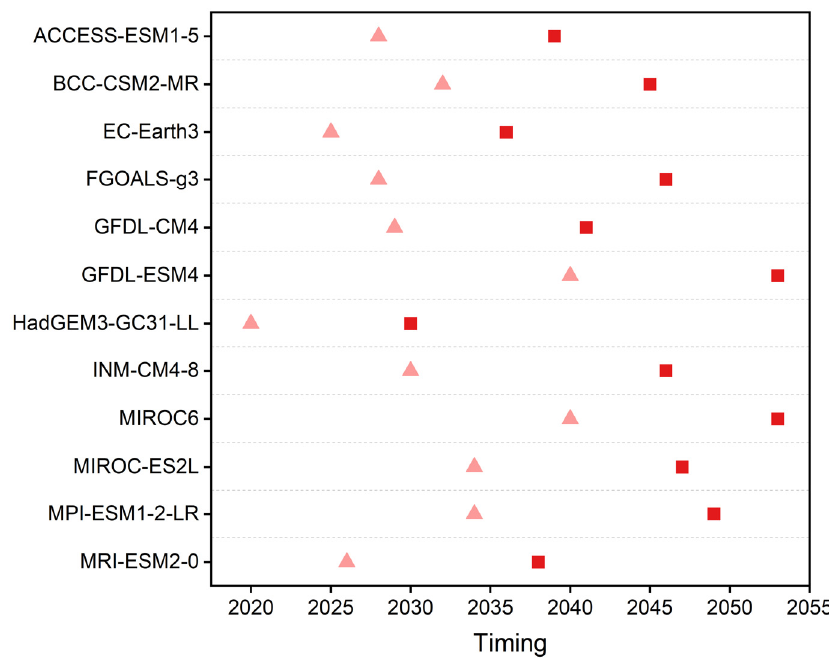
Figure 2. Timing to reach 1.5 ◦ C (pink triangles) and 2 ◦ C (red squares) global warming targets under SSP5-8.5. The year denotes the central timing of a 20-year time